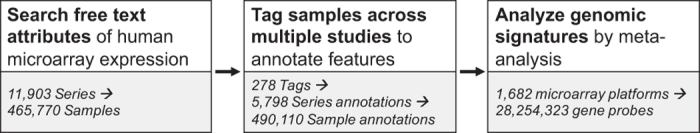
STARGEO.org genomics discovery process.The flow chart shows the three main steps to generate genomic signatures with STARGEO.org. A curator first searches across free text attributes of human microarray expression within GEO. The curator then tags samples across multiple studies to annotate features such as disease status or experimental condition. Finally, users can generate biological genomic signatures of functional gene expression for a given phenotype or experimental condition by meta-analysis.